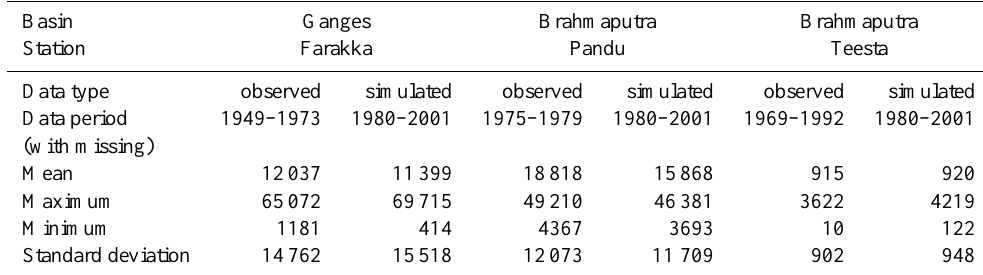
Table A1. Comparison between observed (data source: GRDC) and simulated discharge (m 3 s − 1 ) at the Farakka gauging station in the Ganges Basin, and Pandu and Teesta stations in the Brahmaputra Basin.